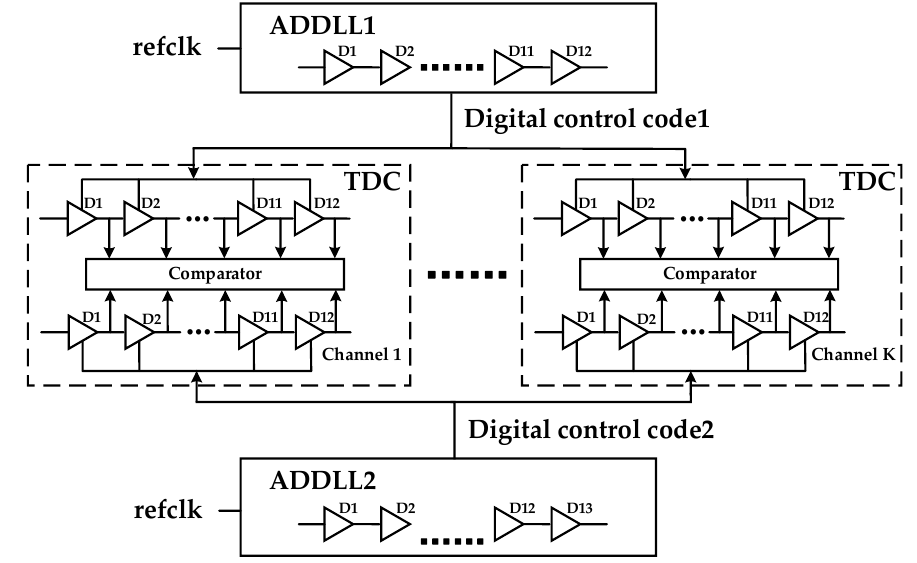
Figure 1. ADDLL applied to Multi-Channel Vernier TDC.